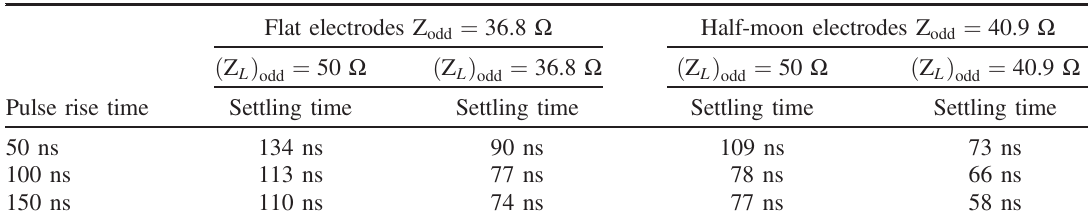
TABLE IV. Settling time, to (cid:1) 0 . 02% , as a function of pulse rise time, stripline odd mode impedance, and value of terminating